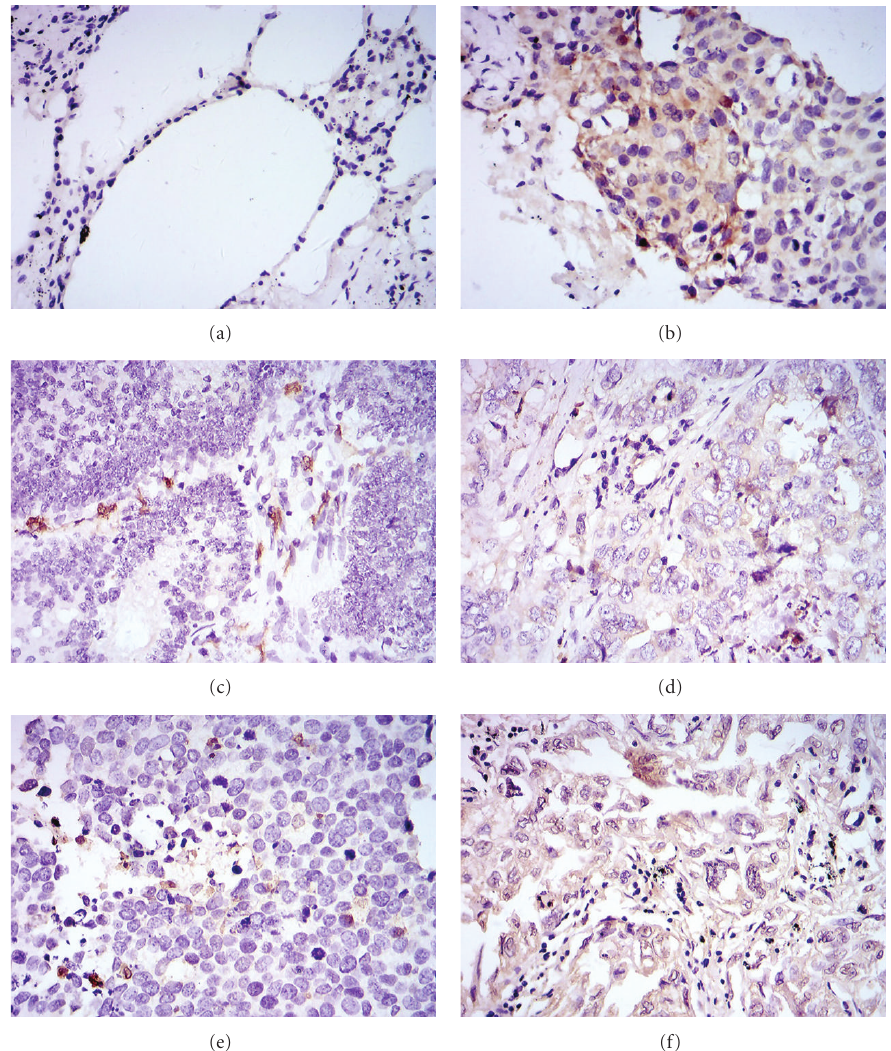
Figure 6: Immunohistochemistry staining in tissue chip of S100A9 protein expression in lung cancer tissue and normal tissues ((a) normal lung tissue, (b) lung squamous cell carcinomas, (c) metastatic carcinoma, (d) adenocarcinoma, (e) small cell carcinoma, (f) large cell carcinoma